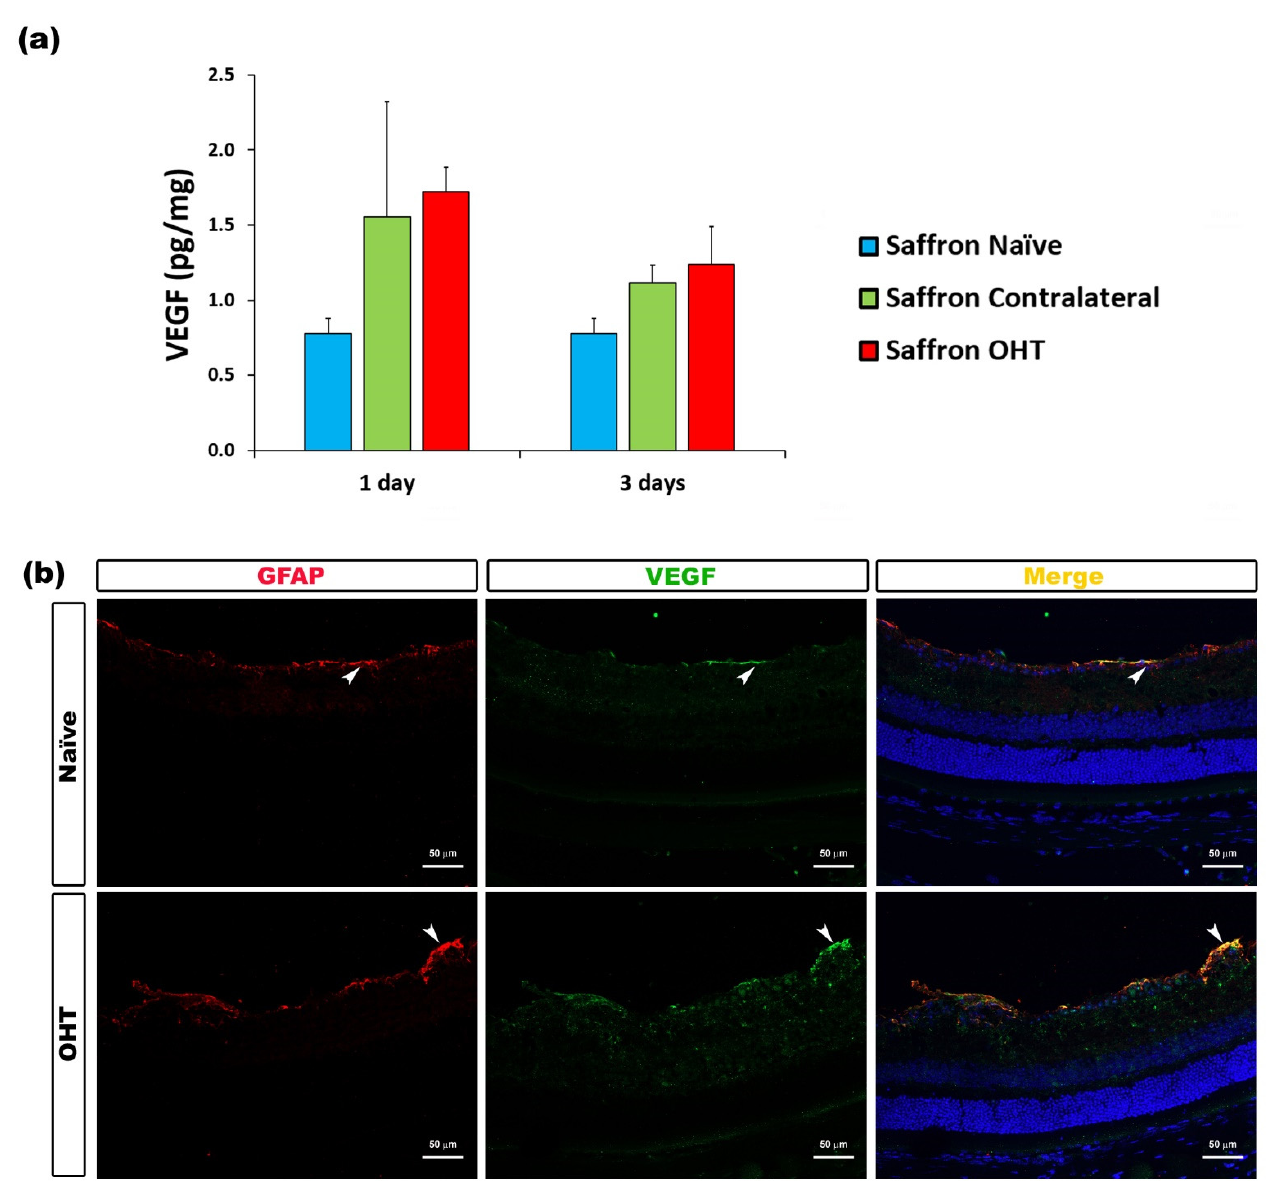
Figure 10. VEGF levels at 1 and 3 days after laser-induced ocular hypertension (OHT). ( a ) The VEGF values obtained in the multiplex assay. The histogram shows the mean levels ( ± SD) of VEGF (pg/mg) at days 1 and 3 after laser OHT induction in saffron ocular hypertension eyes (saffron OHT) and saffron-contralateral eyes (saffron-contralateral) as well as in saffron-naïve eyes. ( b ) Immunohistochemical study of VEGF expression in saffron OHT eyes one day after unilateral laser-induced OHT. Retinal sections were immunolabeled with antibodies to VEGF (green) and GFAP (red). Merge is denoted by the colour yellow. The arrowhead shows the co-expression of GFAP and VEGF in saffron OHT and saffron-naïve eyes. Abbreviations: OHT (ocular hypertension); VEGF (vascular endothelial growth factor); GFAP (glial fibrillary acidic protein).